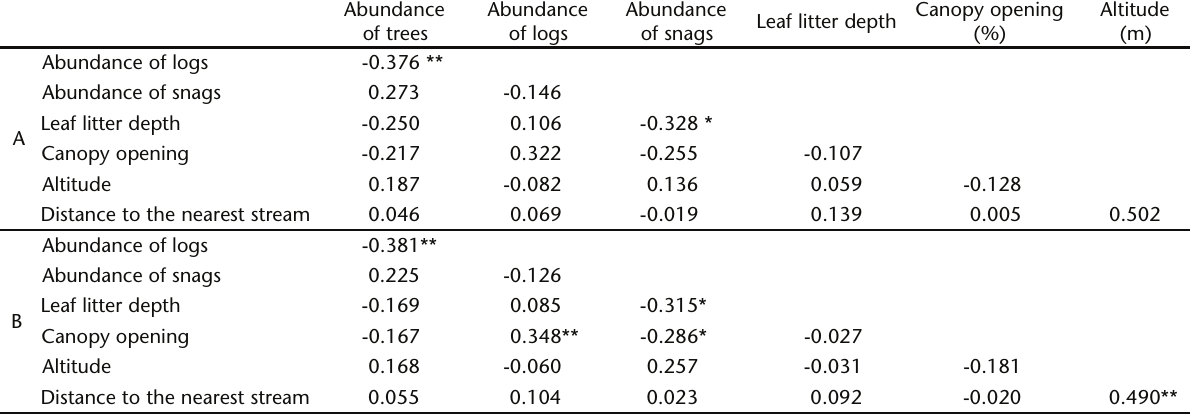
Table I. (A) Pearson correlation matrix for the forest structure components recorded in areas with L. cristata along the 18 transects of 8 km length at Ducke Reserve, Central Amazon. (B) Pearson correlation matrix for the forest structure components recorded in 120 areas, 60 of them with and 60 without L. cristata (see